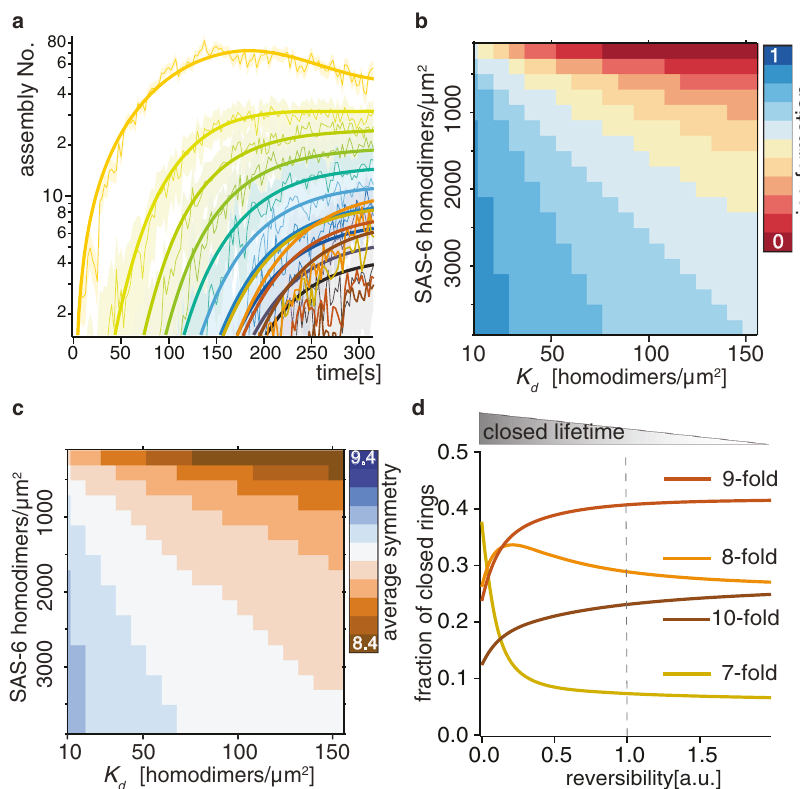
Fig. 4 Modeling of surface SAS-6 self-assembly. a Fit with coagulation-fragmentation model (overlaid thick lines) of the experimental evolution over time of SAS-6 assembly reaction from Fig. 3c. b , c Model predictions of average ring formation ef fi ciency ( b ) and average ring symmetry ( c ) at varying K d and SAS-6 homodimers/ μ m 2 . d Fraction of closed rings of indicated symmetries calculated as numerical solution of the fi tted model after 17 min as a function of closed lifetime (1 = experimental values, <1 slower opening, >1 faster